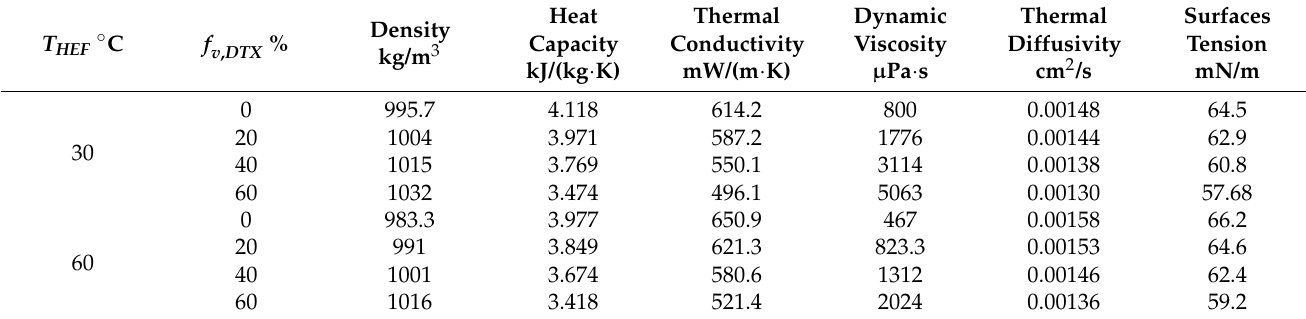
Table 5. Thermophysical properties of